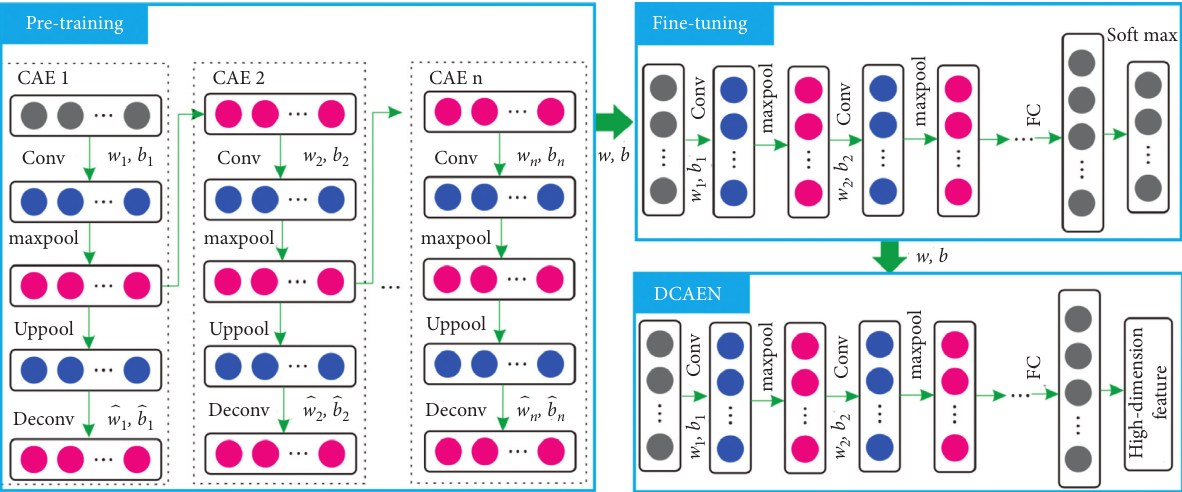
Figure 2: The structure of